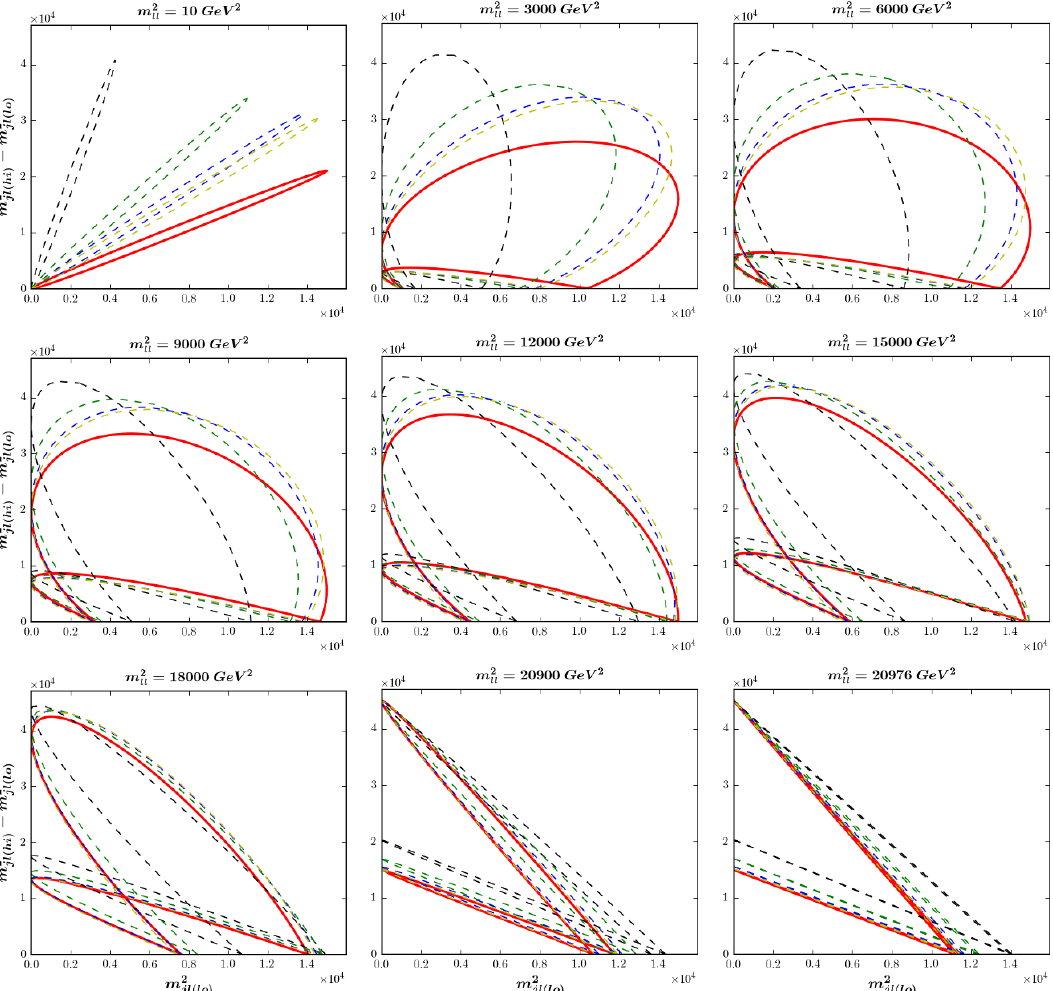
Figure 10 . The same as (cid:12)gure 9, but for the auxiliary branch going through regions (2 ; 3) and (4 ; 3). The dashed lines represent points with ~ m A = 100 GeV (black), ~ m A = 500 GeV (green), ~ m A = 2000 GeV (blue) and ~ m A = 6000 GeV (yellow). For reference, we also show the case of the true mass spectrum for point P 31 (red solid lines), although P 31 does not belong to the auxiliary